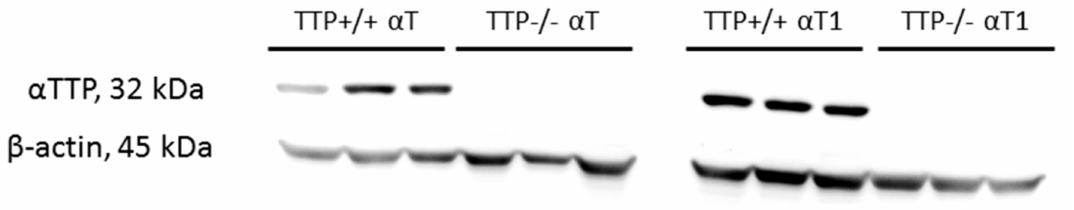
Figure 2. Representative Western blots of hepatic α -tocopherol transfer protein (TTP) expression in TTP +/+ and TTP − / − mice (n = 11) used in the feeding trial.